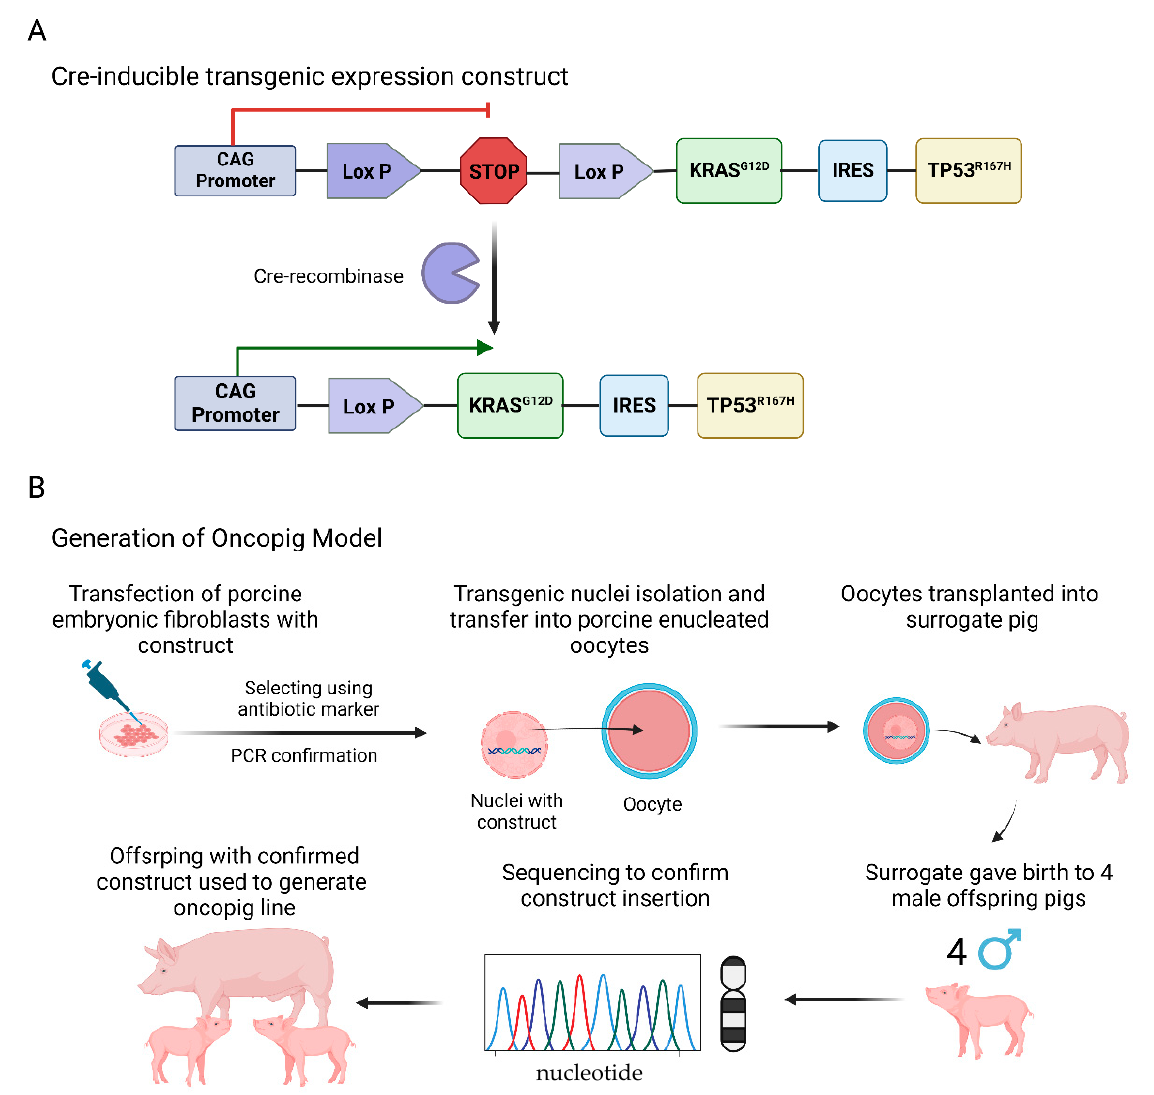
Figure 2. Development of the Oncopig model. ( A ) Development of the Cre-inducible transgene construct. ( B ) Steps used for creation of the Oncopig cancer model. Figure created with